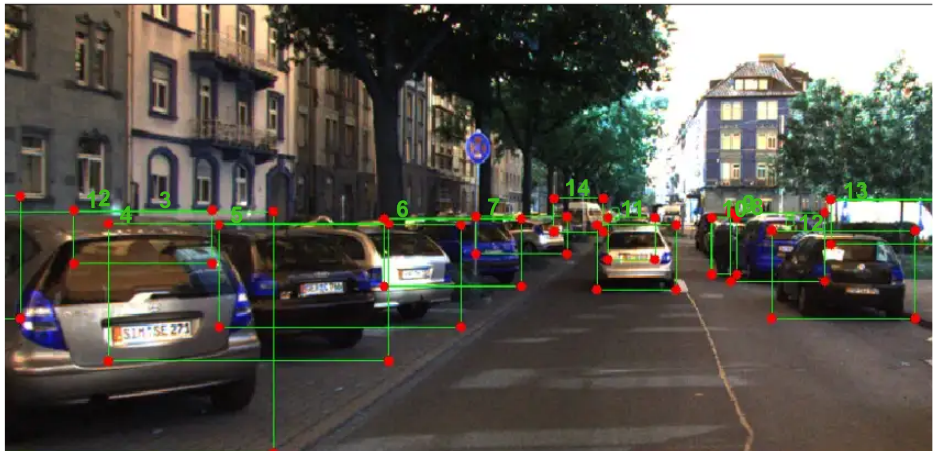
Figure 4. Object detection from the trained CNN model from the KITTI benchmark dataset. The object detection in this figure is represented using the boundary boxes that occupy the various objects such as parking vehicles, moving